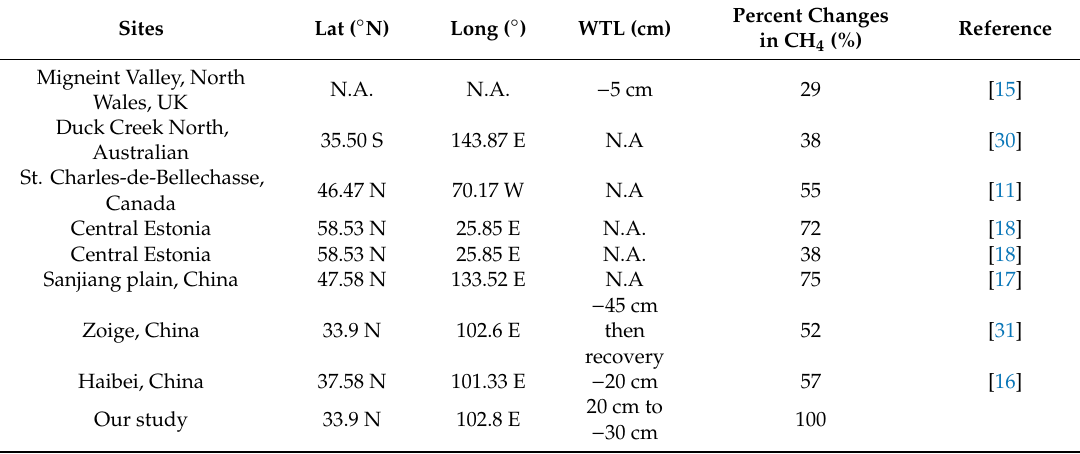
Table 3. Comparison of the percent changes of CH 4 emissions with other